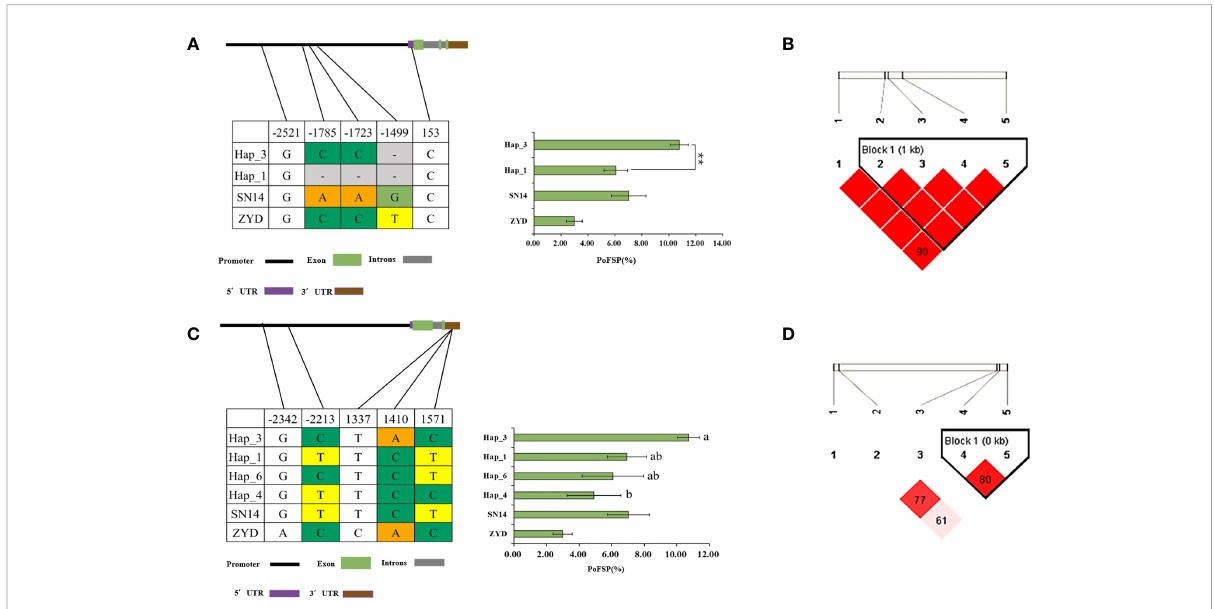
FIGURE 10 Haplotype analysis results of Glyma.13G126400 and Glyma.13G126700. (A) : Correlation analysis of the major haplotype phenotype in Glyma.13G126400. (B) : LD analysis of SNPs among major haplotypes of Glyma.13G126400 . (C) : Correlation analysis of the major haplotype phenotype in Glyma.13G126700. (D) : LD analysis of SNPs among major haplotypes of Glyma.13G126700. a,c : “ ** ” indicates a signi fi cant difference at the 0.01